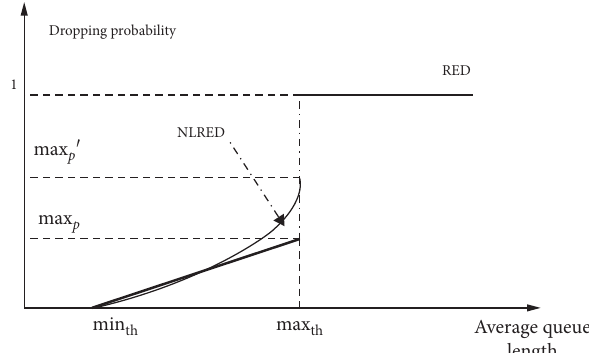
Figure 1: Packet dropping probability functions of RED and NLRED methods